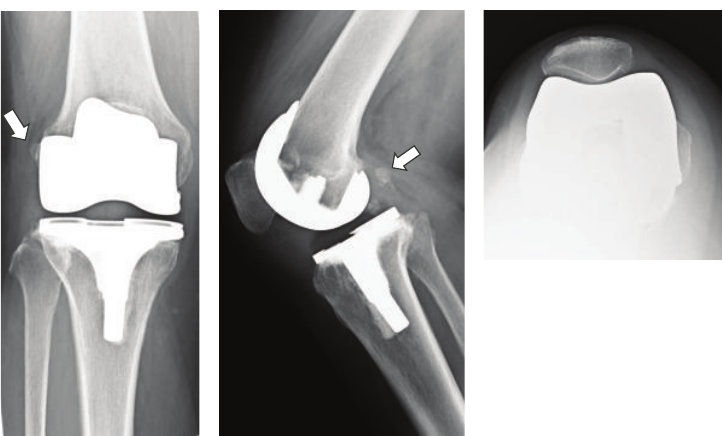
Figure 1: Plain radiographs on first visit; the white arrow identifies the